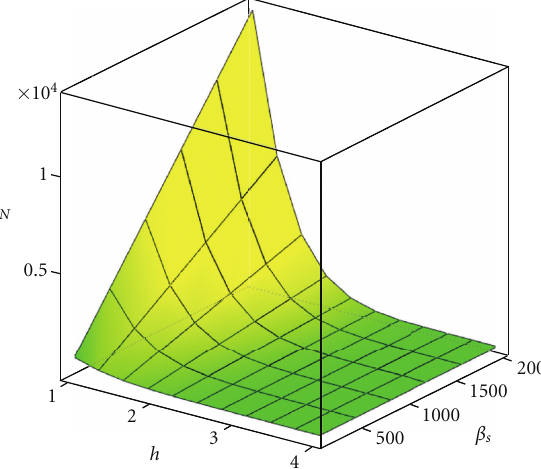
Figure 5: I N ( h , β s ) for w c = 100 ( ψ = 0 . 1), Elastic Range.